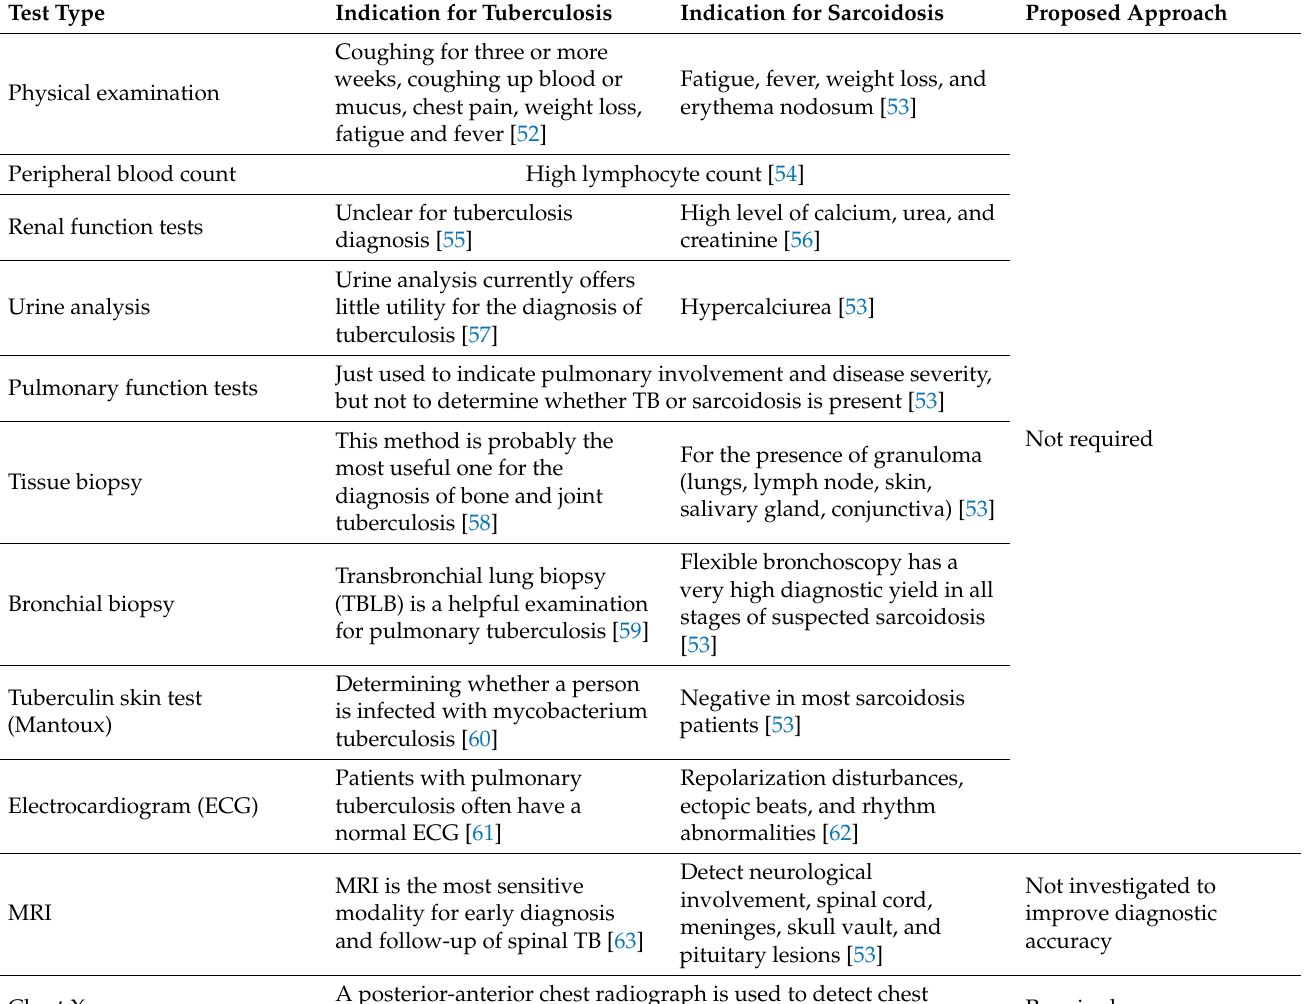
Table 6. Comparison between conventional diagnostic tests for sarcoidosis, tuberculosis, and the proposed